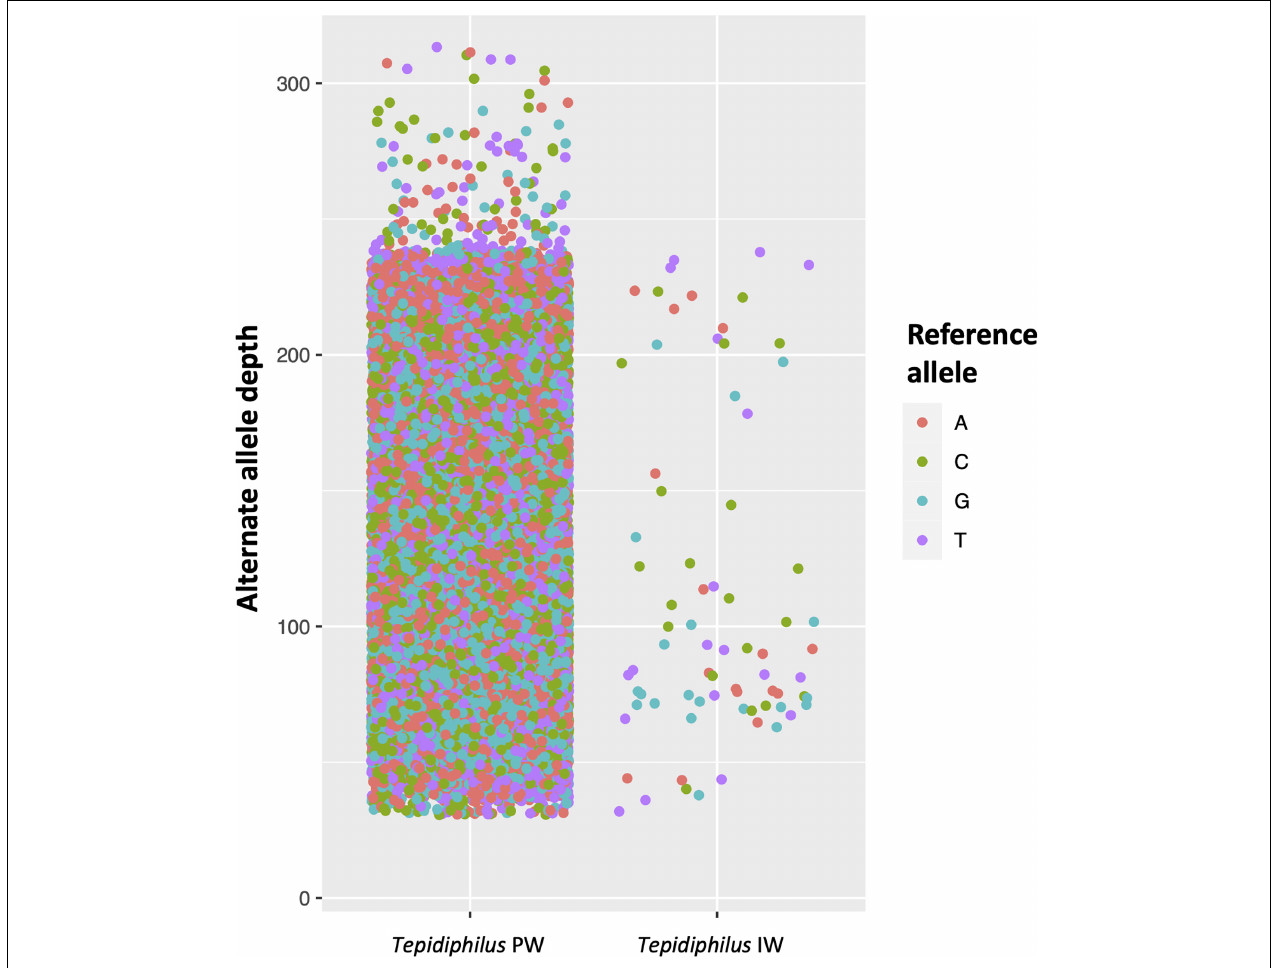
FIGURE 6 | Genomic variations among Tepidiphilus genomes present within the injection (IW) and produced waters (PW). Detection of single nucleotide variants -SNVs- in the Tepidiphilus genomes. Each dot represents high-quality SNVs detected in the shotgun reads of the PW and IW. The respective reference base (Reference Allele) is represented as different colors. The Y -axis depicts the read depth for each SNV observed. In the IW, 95 alternative bases were detected while in the PW 32,567 high-quality alternate alleles were